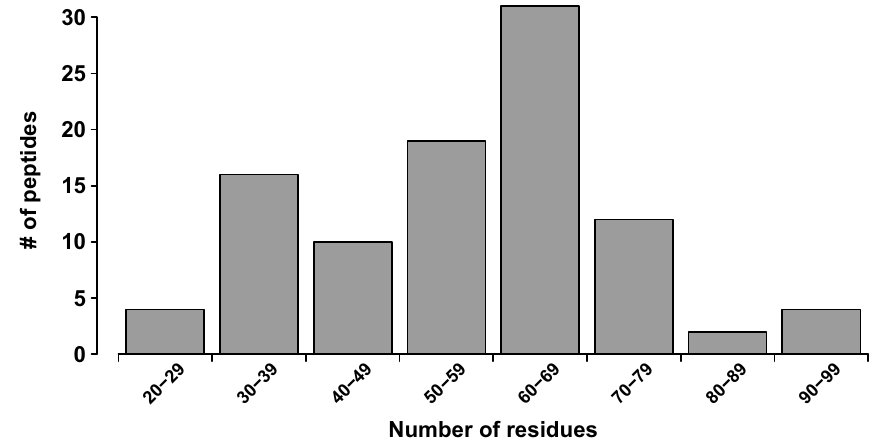
Figure 2. Size distribution of peptides identified in the Lampona venom proteome.